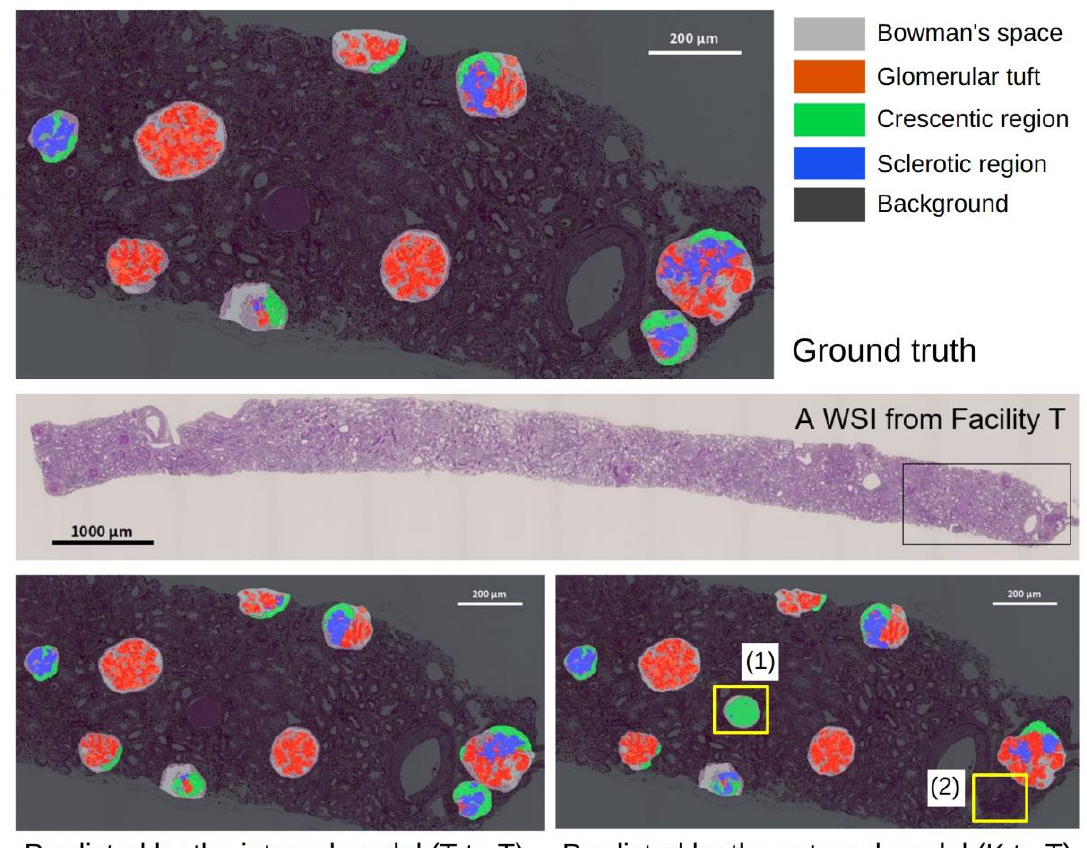
Figure 3. Example of the results of a whole slide image (WSI) from facility T. Top : manually annotated glomeruli and their components (i.e., ground truth). Middle: The WSI of the renal sample. The box is the area depicted in the top and bottom images. Bottom left : The predicted result obtained by model T (i.e., internal model). Bottom right : The predicted result obtained by model K (i.e., external model). In the example of the predicted result in the bottom right (K to T), (1) a dilated tubule filled with Tamm–Horsfall protein is incorrectly detected as glomerulus, and (2) a glomerulus is undetected, both of which are due to errors that occurred in the detection process in the first step of the computational